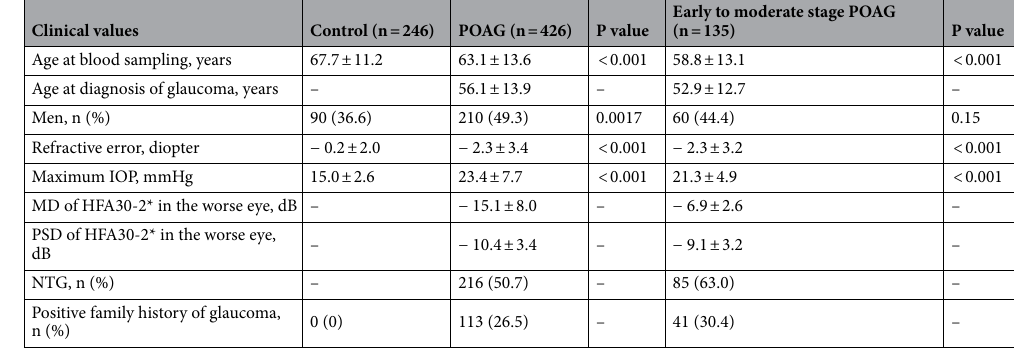
Table 1. Demographic and clinical data in patients with primary open-angle glaucoma and control subjects. Early to moderate stage POAG is a subset used for PSD analyses. Continuous variables are expressed as mean ± standard deviation. Fisher exact test for comparison of proportion and Student t test for continuous variables. POAG primary open-angle glaucoma, IOP intraocular pressure, MD mean deviation, HFA30-2 Humphrey field analyzer 30–2, PSD pattern standard deviation, NTG normal tension glaucoma. *Automated static perimetry.